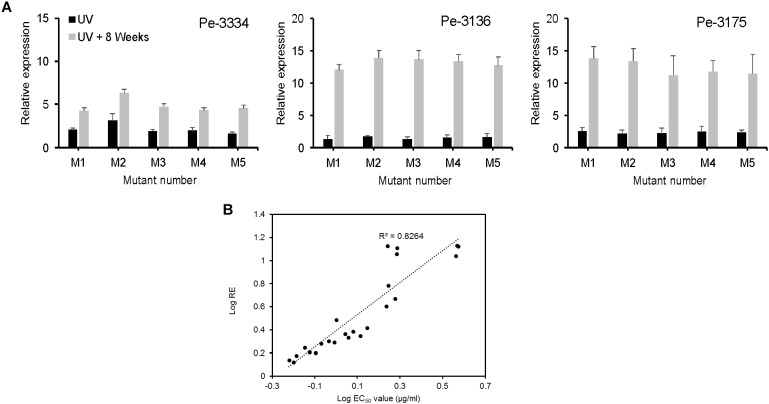
Constitutive expression of PeCYP51 in Penicillium expansum and correlation with isolates sensitivity. (A) The relative expression was calculated with the reference β-actin gene using the 2-ΔΔCt method for 5 mutants from each of the three WT-isolates Pe3334, P3136, and Pe3175 after UV excitation (black columns) or after 8 weeks of selection pressure on MEA amended with 2.5 μg/ml (gray columns). The EC50 values of the mutants are shown in Table 1. The final relative expression (RE) was expressed as the RE in the mutant relative to the RE in the respective wild-type isolate. (B) Correlation between the LogEC50 values of the P. expansum mutant isolates and their relative CYP51 expression.